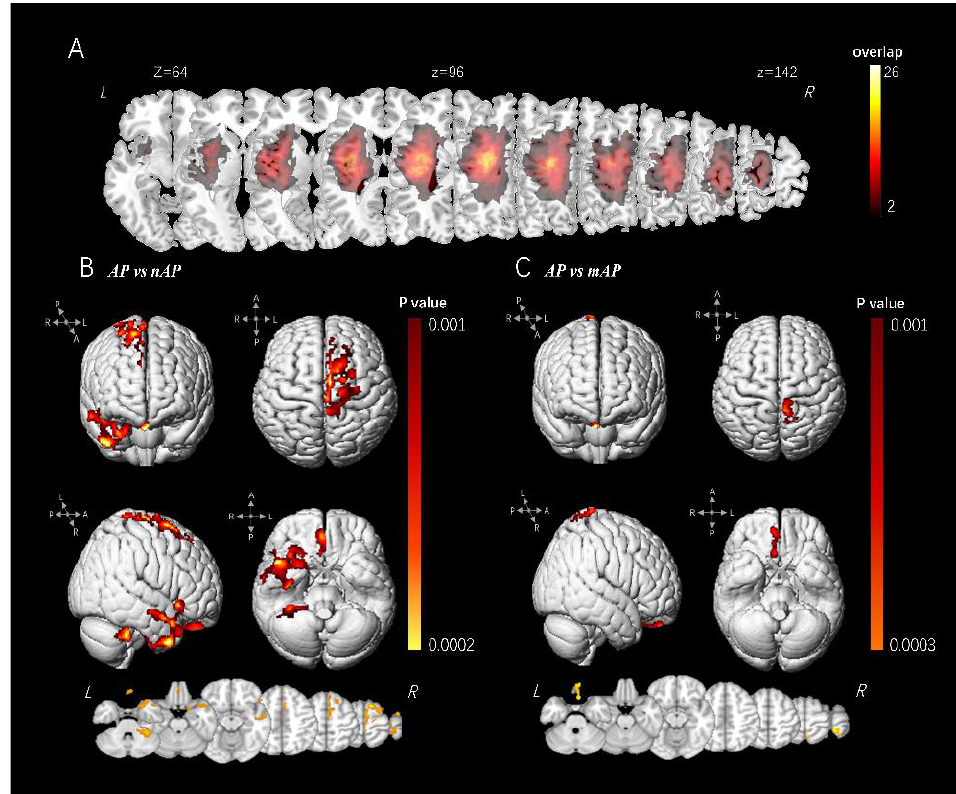
Figure 1. Tumor overlapping map and regions with group difference. ( A ): The tumor overlapping map of all enrolled patients. The color of each voxel indicates the number of overlap (1 – 26). ( B , C ): Significant clusters of inter-group comparisons identified by VBM, with 3-D rendered figures on the top and transverse map on the bottom. The color indicates p value, ranging from 0.001 (dark red) to 0.0002 (light yellow).